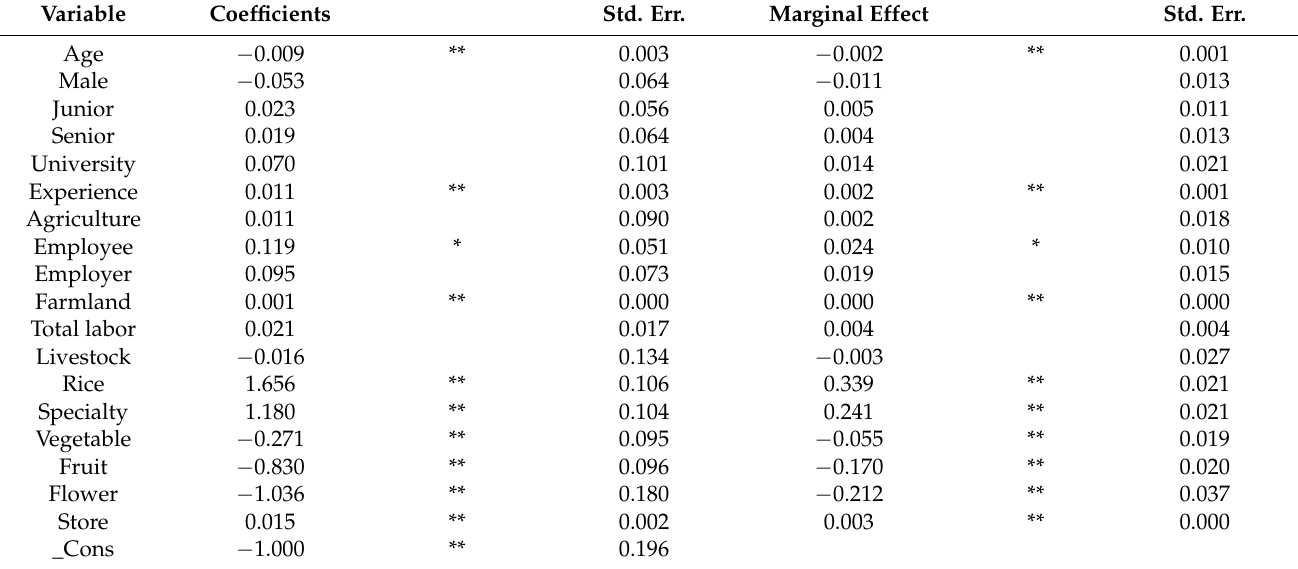
Table 2. Estimates of the probit